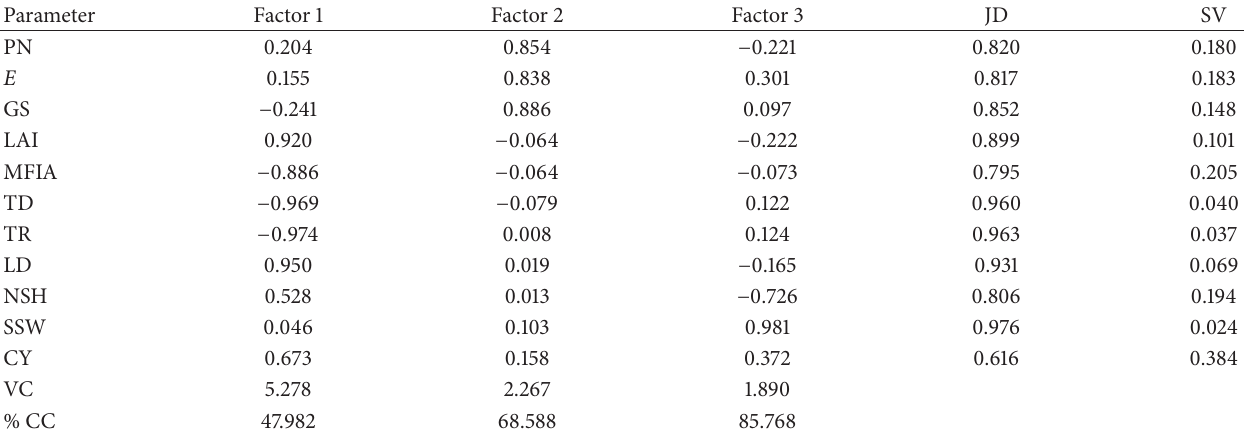
Table 7: Loading matrix of varimax orthogonal rotation factor in sugarcane varieties.